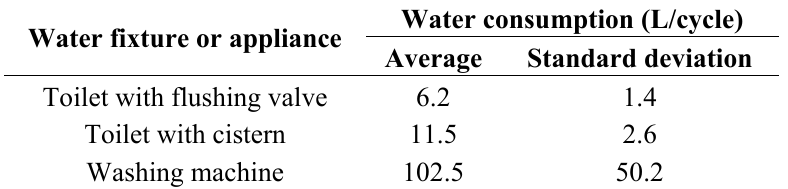
Table 3. Water consumption per cycle of water fixtures and appliances in low-income